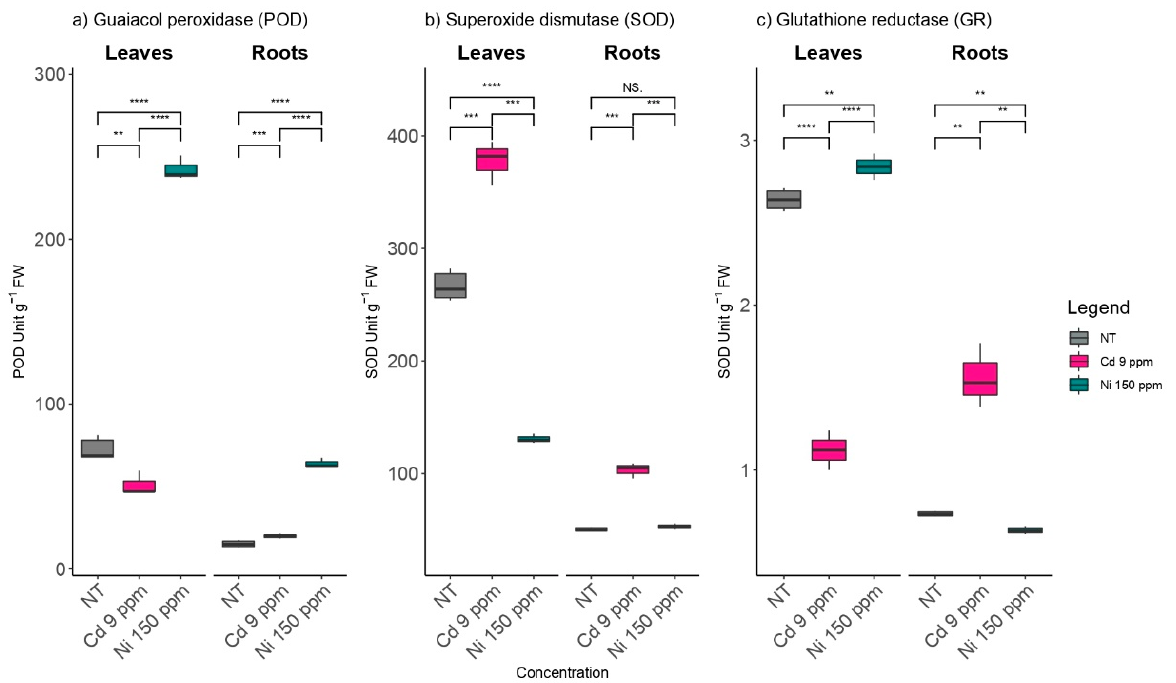
Figure 1. The effects of elevated Cd and Ni soil contents on (a) guaiacol peroxidase (POD); (b) su- peroxide dismutase (SOD), and (c) glutathione reductase (GR) activities at root and leaf levels using NT-non treated soil. Cd 9 ppm-soil was supplemented to 9 mg Cd kg − 1 of soil DW and Ni 150 ppm-soil was supplemented to 150 mg Ni kg − 1 of soil DW. Significance levels: (NS) non-significant versus significant (**) <0.01; (***) < 0.001, and (****) <0.0001.